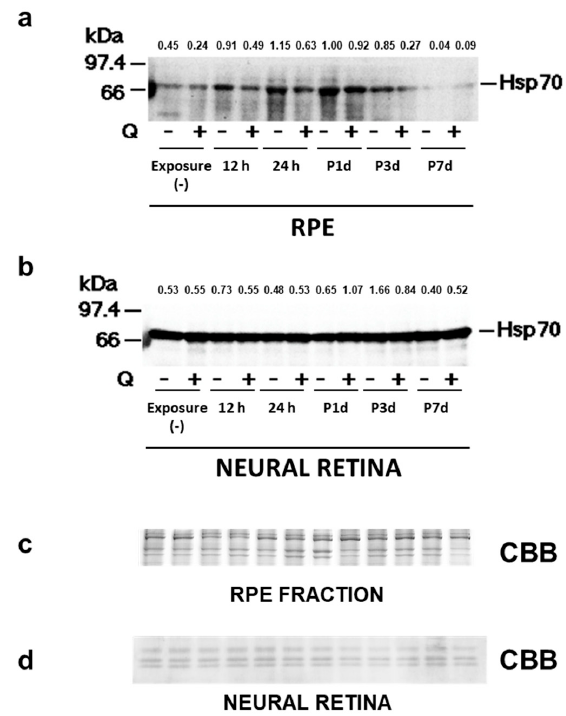
Figure 6. Expression of Heat shock protein 70 (Hsp70). Hsp70-specific labeling of about 66 kDa is seen and enhanced by light exposure. ( a ) The enhanced labeling is suppressed in quercetin (+) RPE cells. ( b ) Hsp70 labeling in the neural retina is unchanged by light exposure, and quercetin treatment does not affect the Hsp70 expression. The sample loading was monitored by staining with Coomassie Brilliant Blue (CBB) R-250, and the correction value with CBB is shown in the upper part. ( c ) RPE fraction and ( d ) neural retina. h, hours; d, day(s); and P, post.